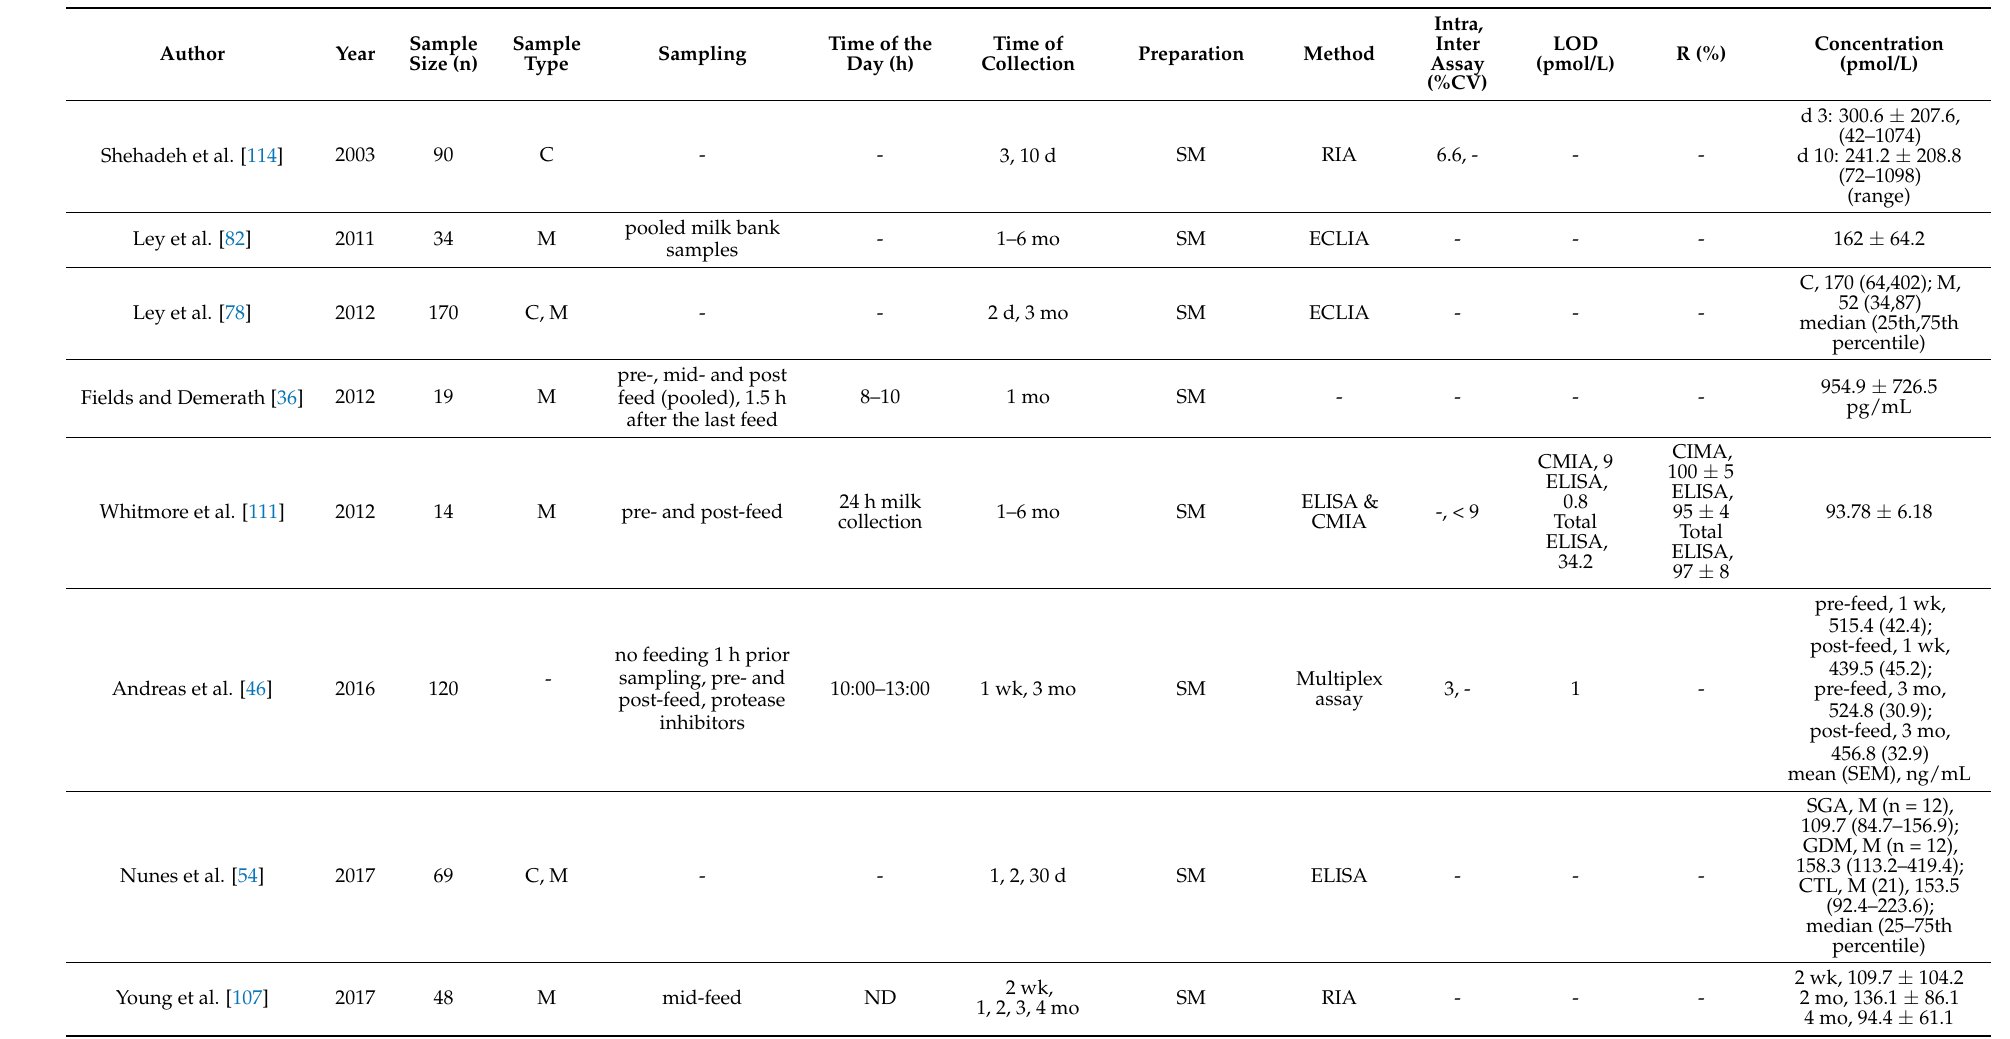
Table 4. Studies examining human milk